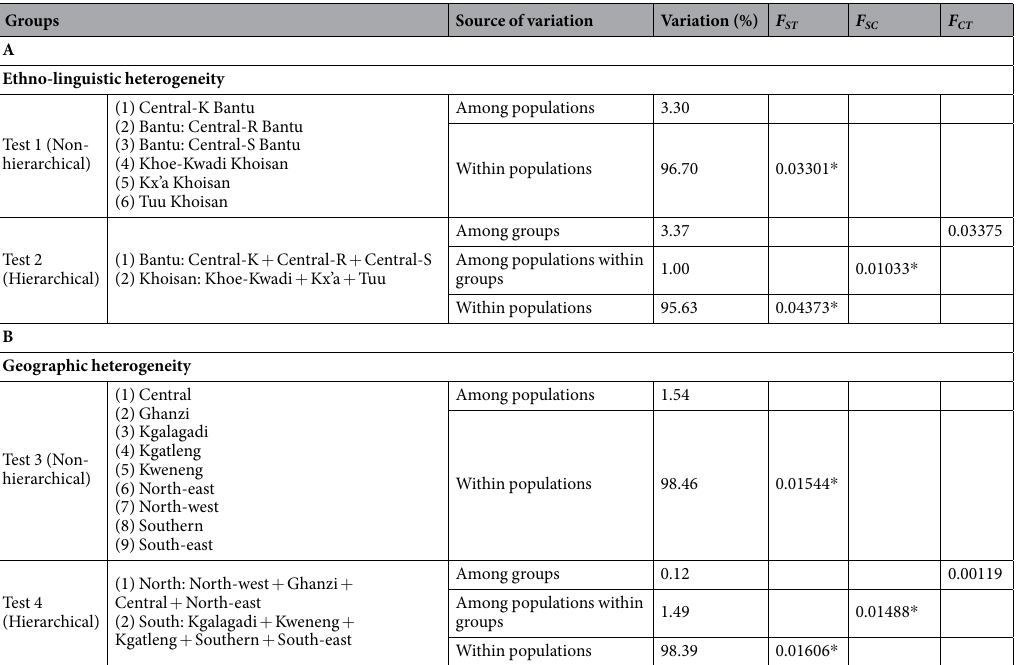
Table 1. Hierarchical and non-hierarchical analysis of molecular variance (AMOVA) between the different Botswana population groups according to ethno-linguistic (A) and geographic (B) heterogeneity. * P <